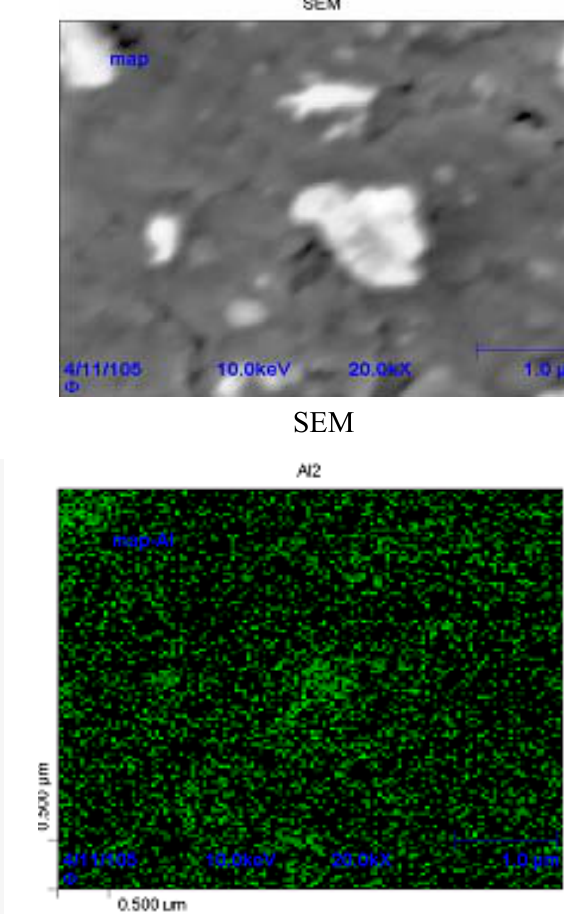
Figure 2. SEM images and Auger maps of (a) Co–WC and (b) Co–Al